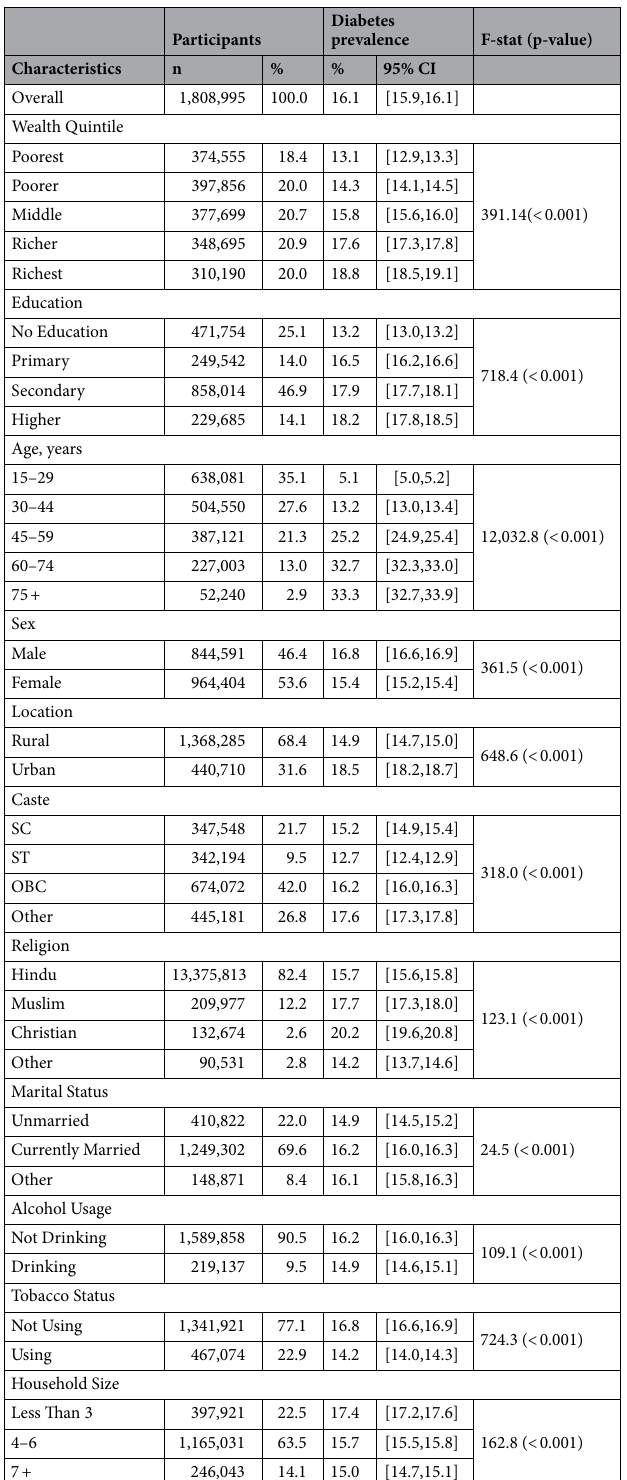
Table 1. Participant characteristics and adjusted diabetes prevalence among adults in India,